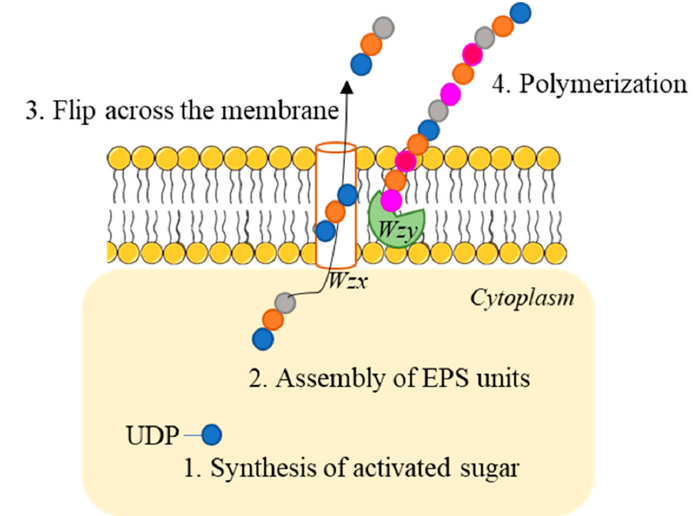
Figure 2. HePS production via Wzy-dependent pathway.